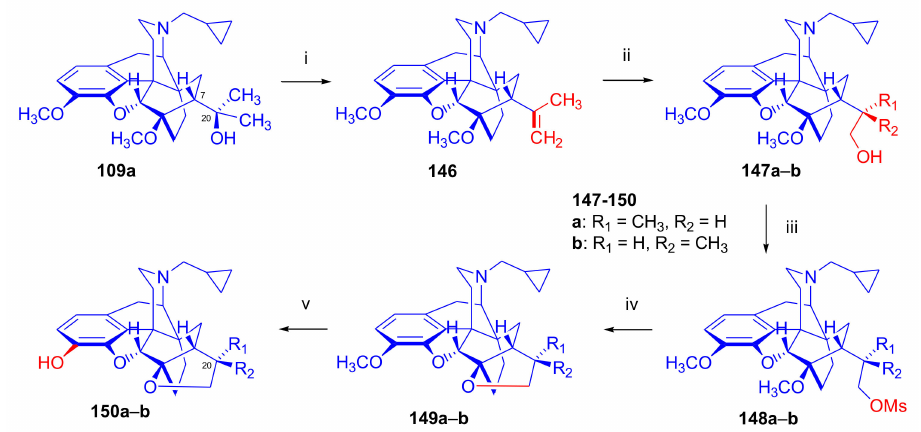
Figure 40. Synthesis of diprenorphine furanomorphides. Reagents and conditions : (i): formic acid, reflux, 12 min; (ii): (1) BH 3 · DMS, THF, (2) H 2 O 2 , 3M NaOH; (iii): MsCl, CH 2 Cl 2 , Et 3 N; (iv): LiAlH 4